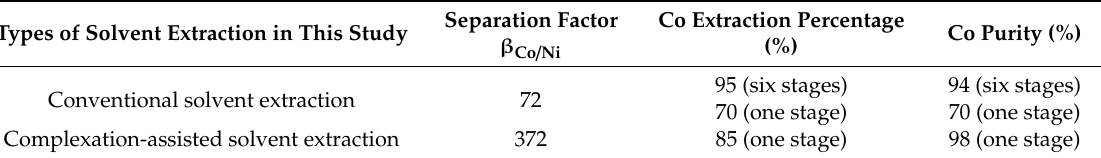
Table 4. Comparison of cobalt–nickel separation factor, cobalt recovery percentage and purity demonstrated by conventional solvent extraction and complexation-assisted solvent